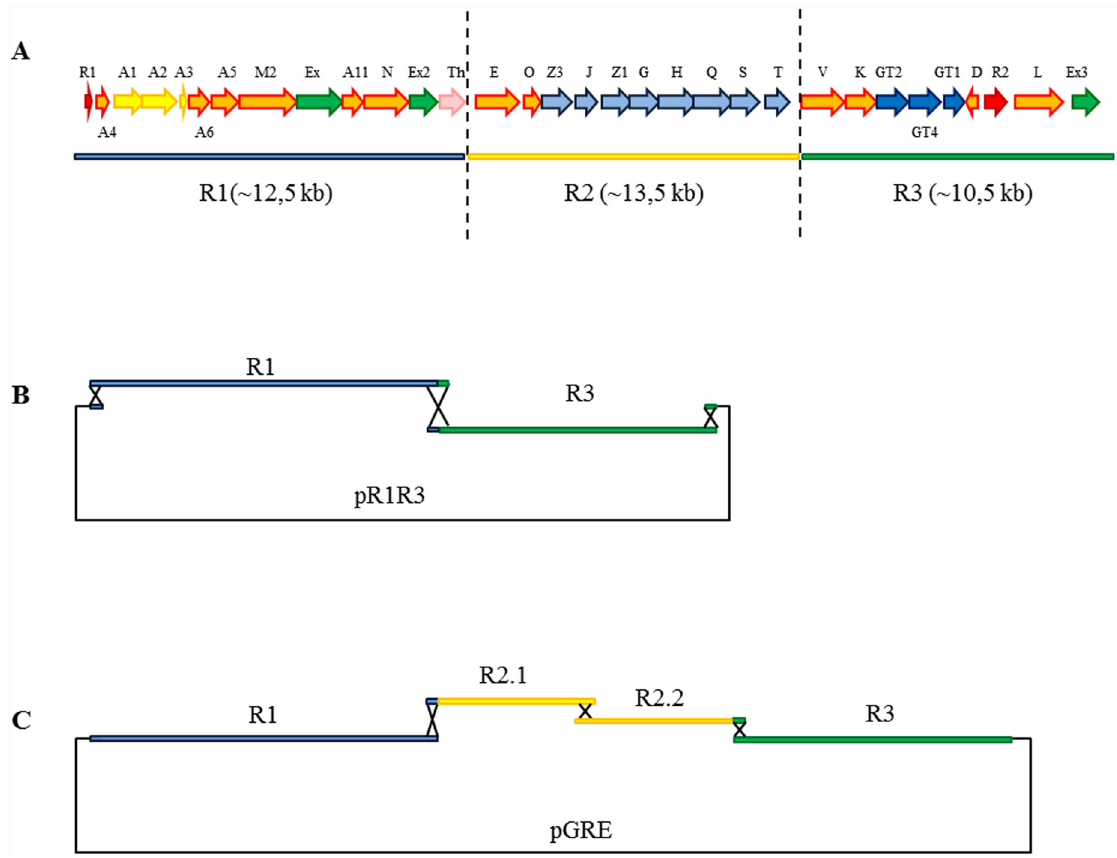
Fig 5. Strategy for assembling the grecocycline biosynthetic gene cluster using TAR. A – gre cluster divided on R1, R2 and R3; B — assembly of pR1.R3; C — assembly of pGRE.